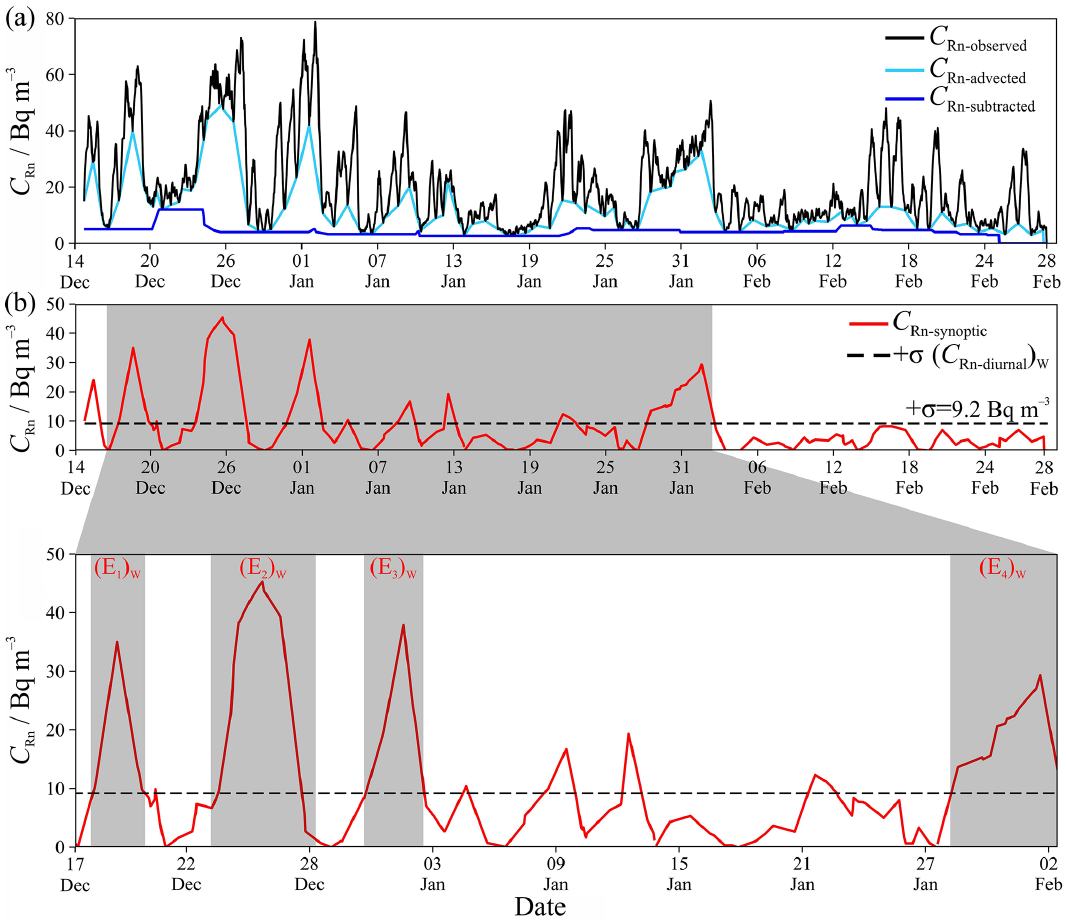
Figure 3. (a) Hourly mean observed radon concentrations, the advected radon contribution with subtracted radon indicated, and (b) isolated synoptic timescale radon contribution in winter with the standard deviation ( + σ ) of the diurnal contribution indicated. Four persistent temperature inversion events (E i ) W detected by the RBM are shown in the shaded area and enlarged in the breakout panel beneath; see text in Sect. 2.3.1 for